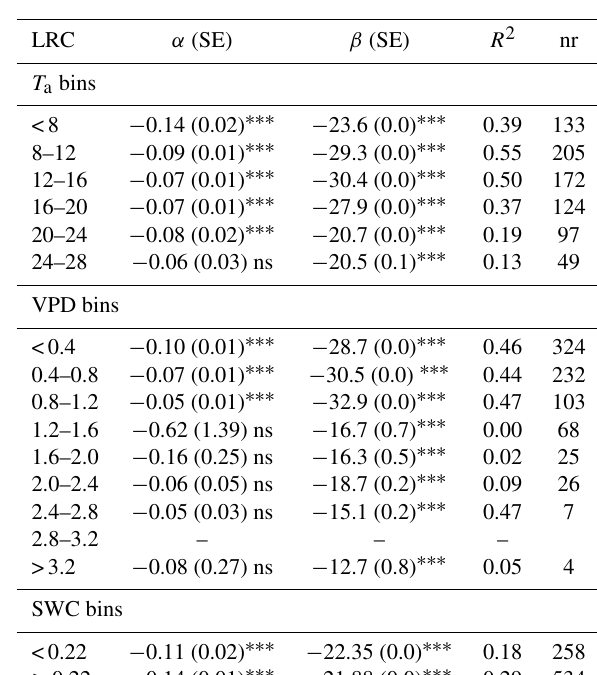
Table 4. Parameters, standard errors and/or the coefficient of de- termination ( R 2 ) of the rectangular hyperbolic light-response curve (LRC) between daily means of midday NEE and incoming radiation ( F sd ) for various T a bins, VPD bins and SWC bins. α : initial slope of LRC and canopy light-utilization efficiency (µmol CO 2 J − 1 ); β : maximum NEE (i.e. uptake rate of the canopy) at light saturation